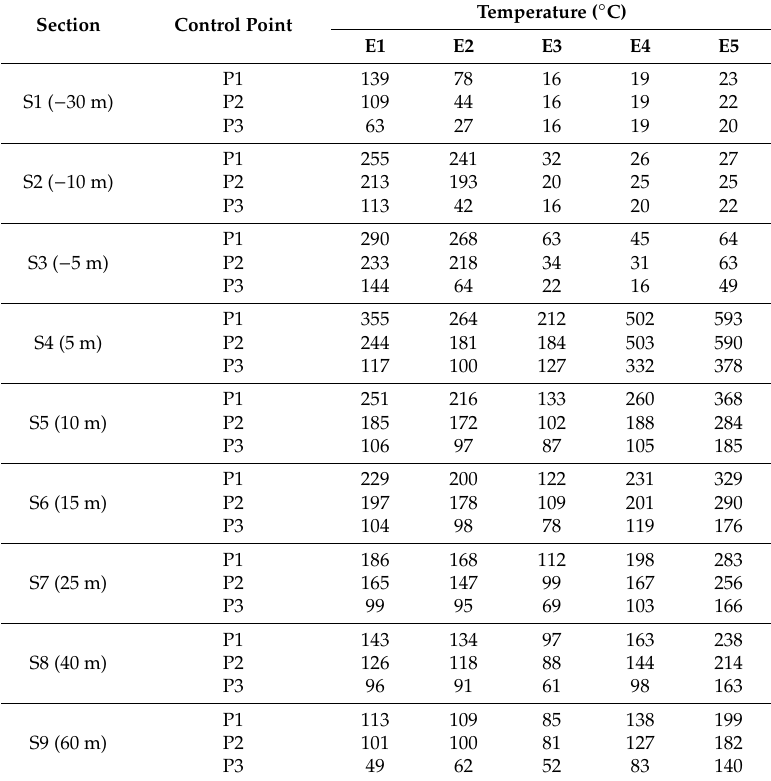
Table 5. Experimental values from the tests.